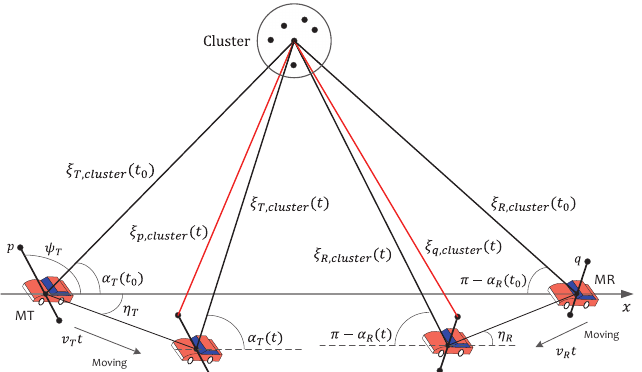
Figure 2. Angular parameters and path lengths of the non-WSSUS channel models for MIMO V2V